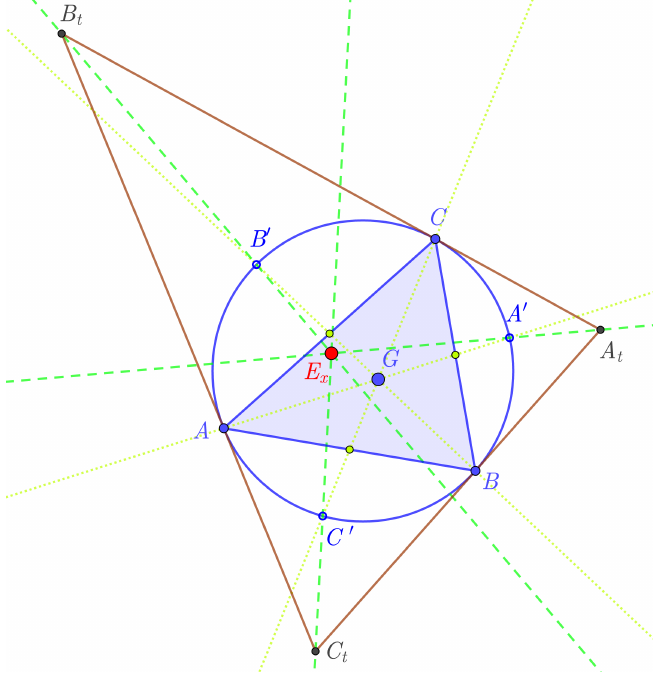
Figure 1. The Exeter point E x